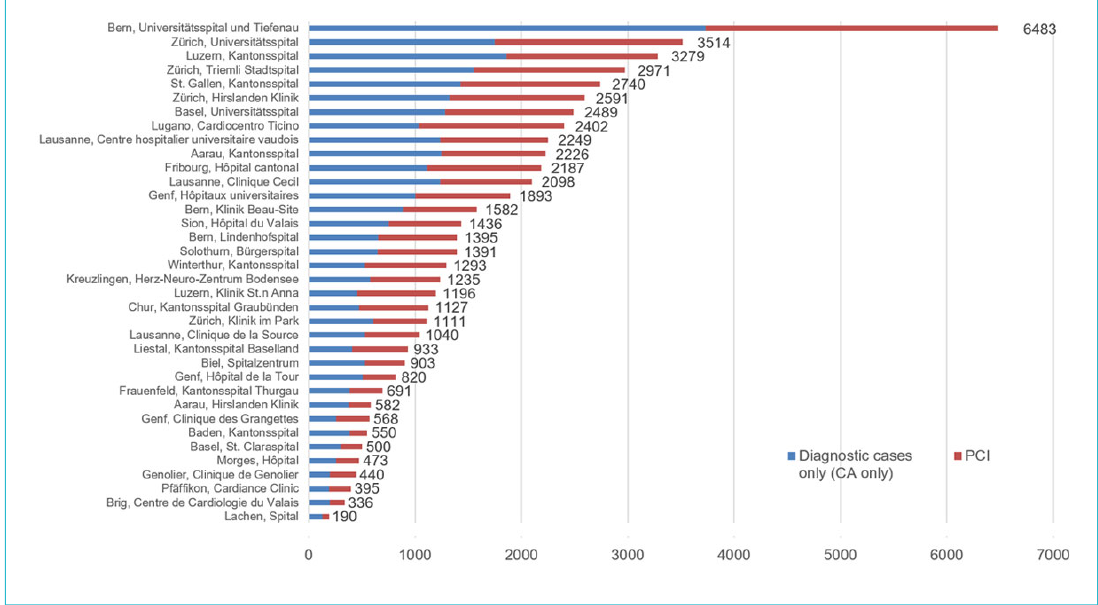
Figure 1: Percutaneous coronary interventions (PCI) during the year 2018 in Switzerland. CA = coronary angiography